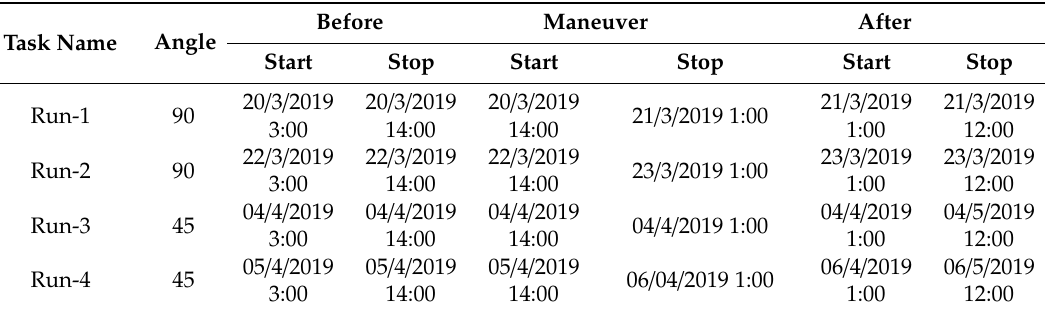
Table 1. LAPAN-A2 satellite maneuver time.